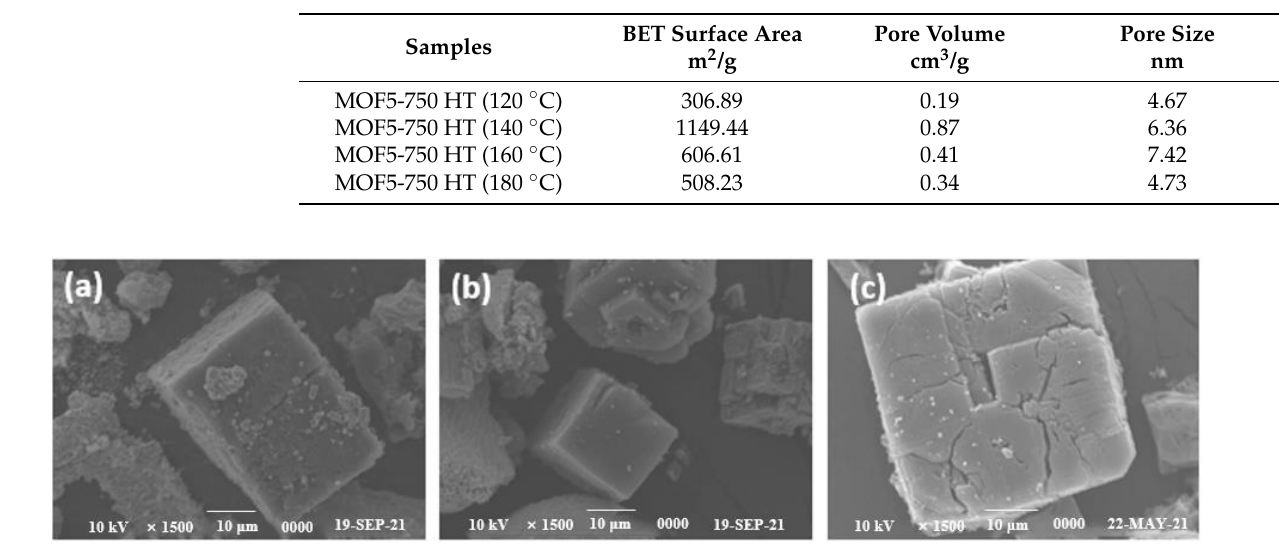
Table 1. Specific surface area, pore volume and pore size data of each sample.